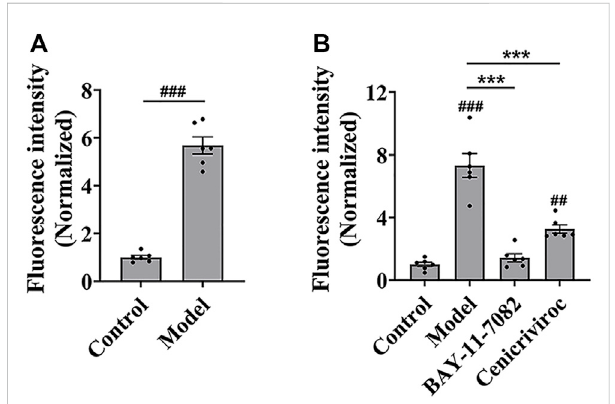
FIGURE 2 The evaluation of in vitro high-throughput screening model for cell adhesion inhibitors. (A) The reproducibility of the cell adhesion model between the stimulated HUVEC cells and labeled THP-1 cells. (B) The adhesion inhibitory activity of BAY-11-7082 and cenicriviroc (CVC) on cell adhesion. HUVEC cells were treated simultaneously by LPS and/or compound (BAY-11-7082 (10 μ M) or CVC (1 μ M)) for 24 h, and then co-cultured with labeled THP-1 cells for 15 min. Data were presented as mean ± SEM over three experiments. ## p < 0.01, ### p < 0.001 vs. control, and *** p < 0.001 vs. model.